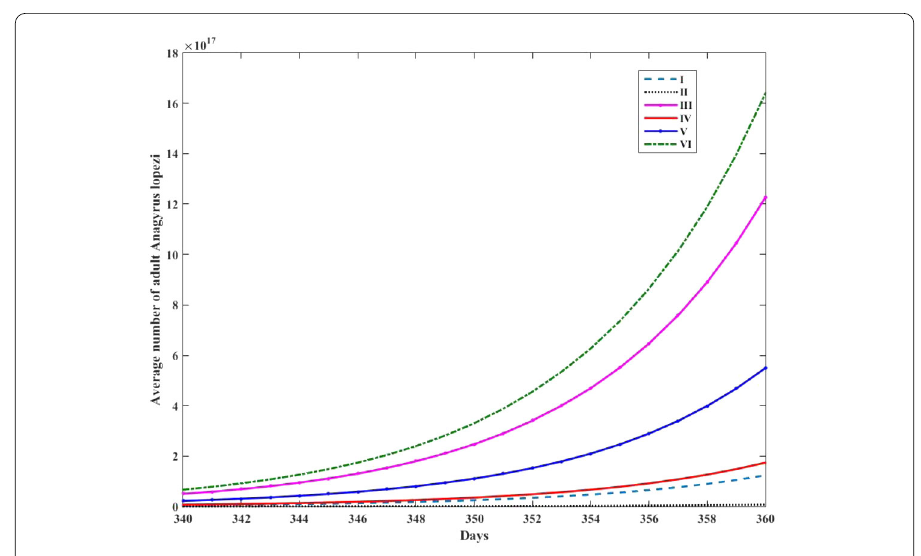
Figure 8 The average number of adult wasps Anagyruslopezi